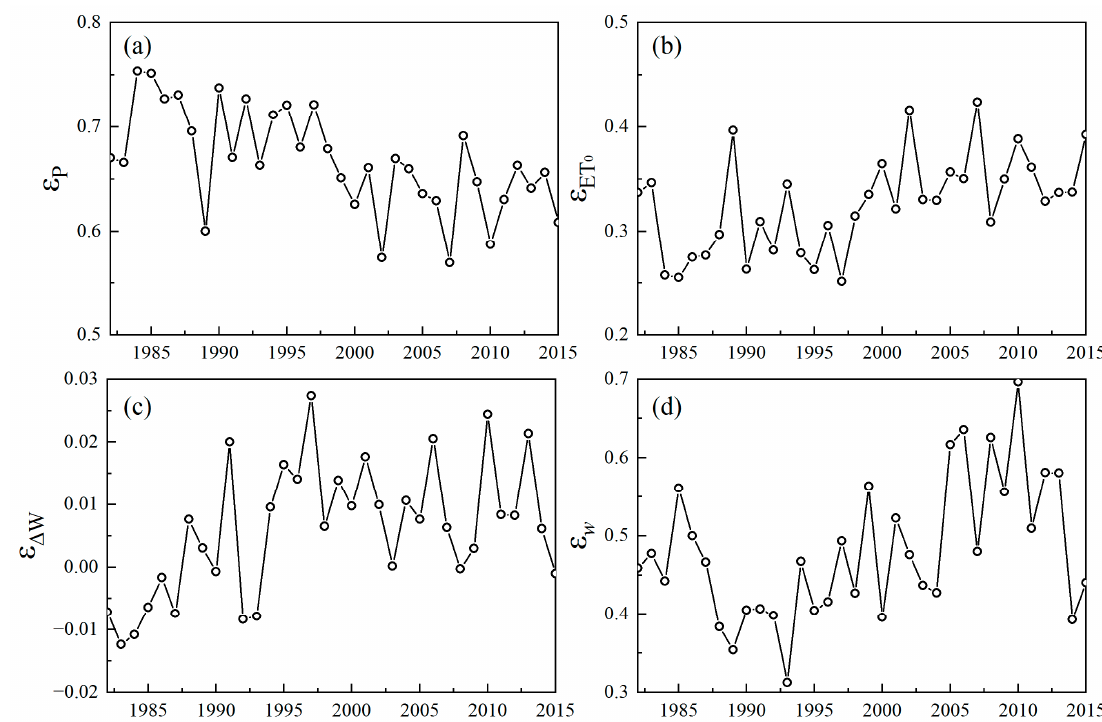
Figure 3. Temporal variations in elasticity coe ffi cients for ( a ) precipitation ε P , ( b ) potential evapo- transpiration ε ET 0 , ( c ) glacier change ε ∆ W and ( d ) landscape condition ε w .